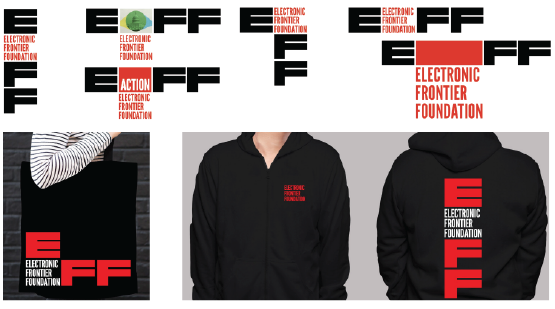
Fig. 3. Examples of EFF’s modular logo and its application.